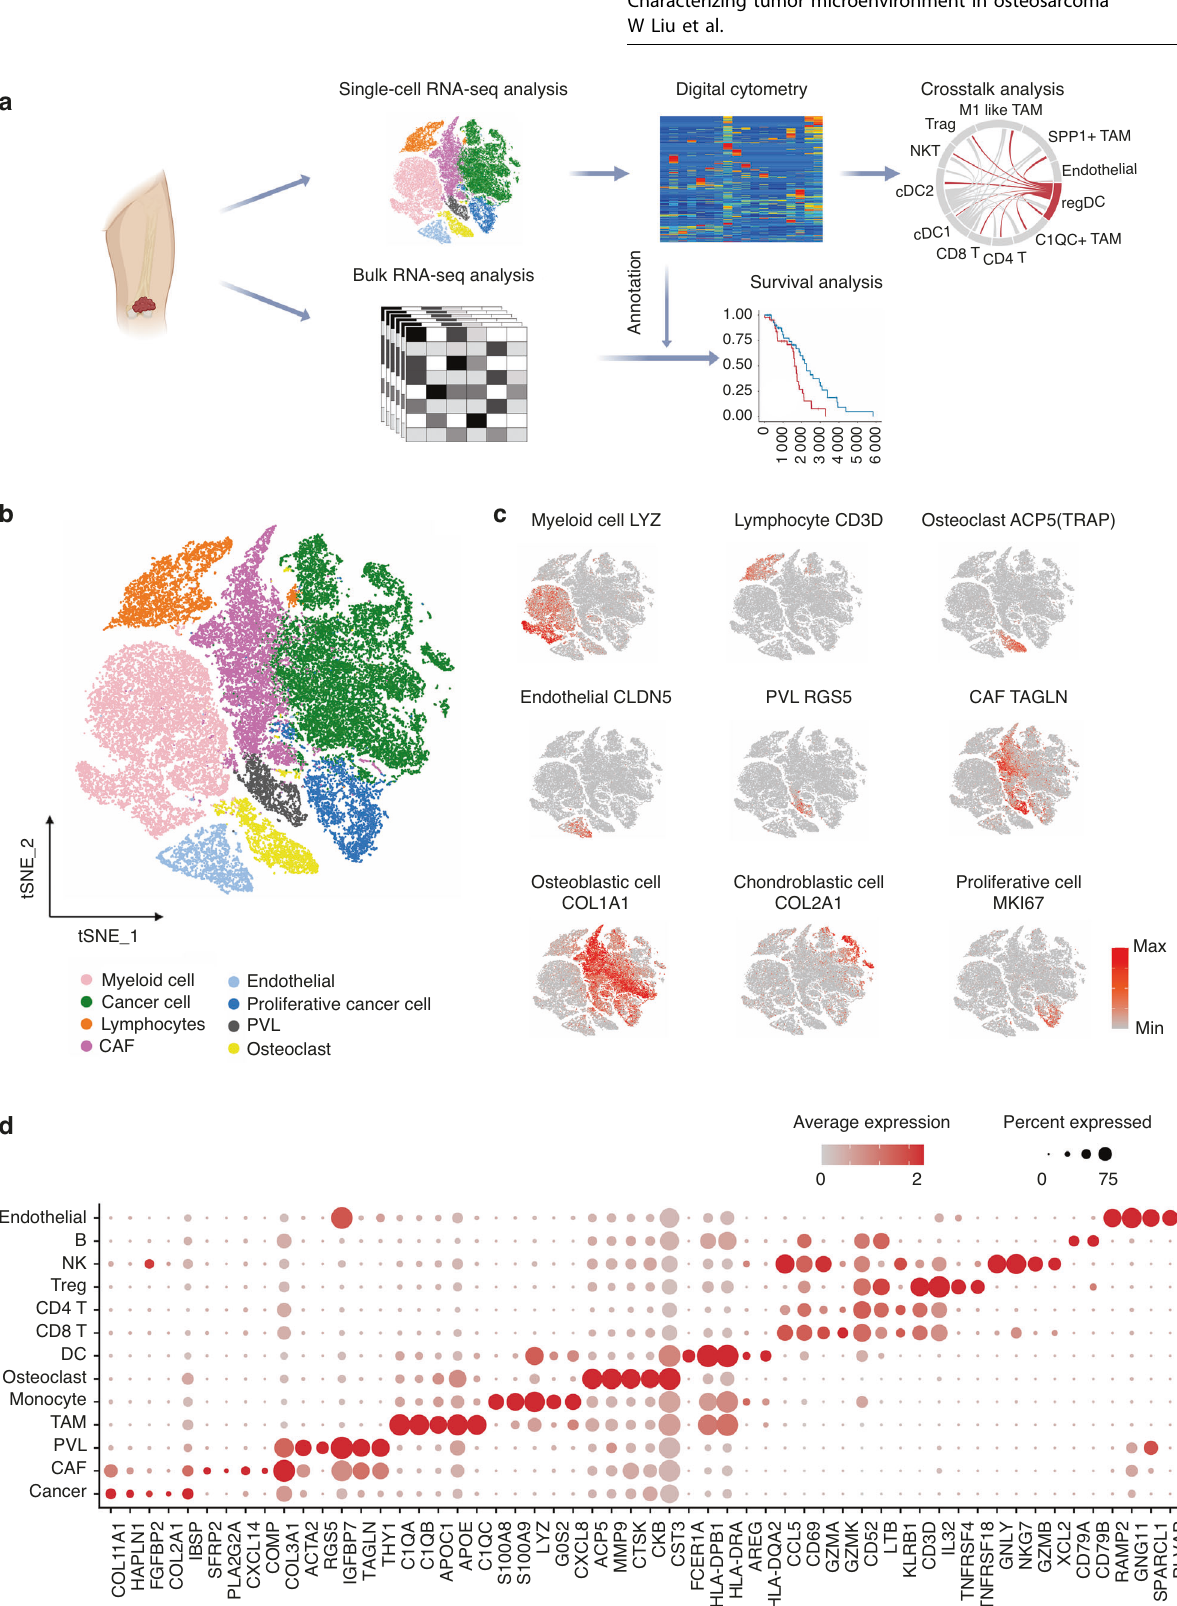
Fig. 1 Overview of the osteosarcoma tumor microenvironment at a single-cell resolution. a Overall design for investigating the tumor microenvironment in osteosarcoma. b T-distributed stochastic neighbor embedding (tSNE) plot of the identi fi ed main cell clusters in OS lesions. c tSNE plots showing the expression of marker genes of the major cell types detected in this study. Red represents high expression; gray represents low expression. d Dot plot showing the speci fi cally expressed genes of the major cell types. Red represents high expression; gray represents low expression. The size of the circle represents the percentage of cells that expressed the indicated